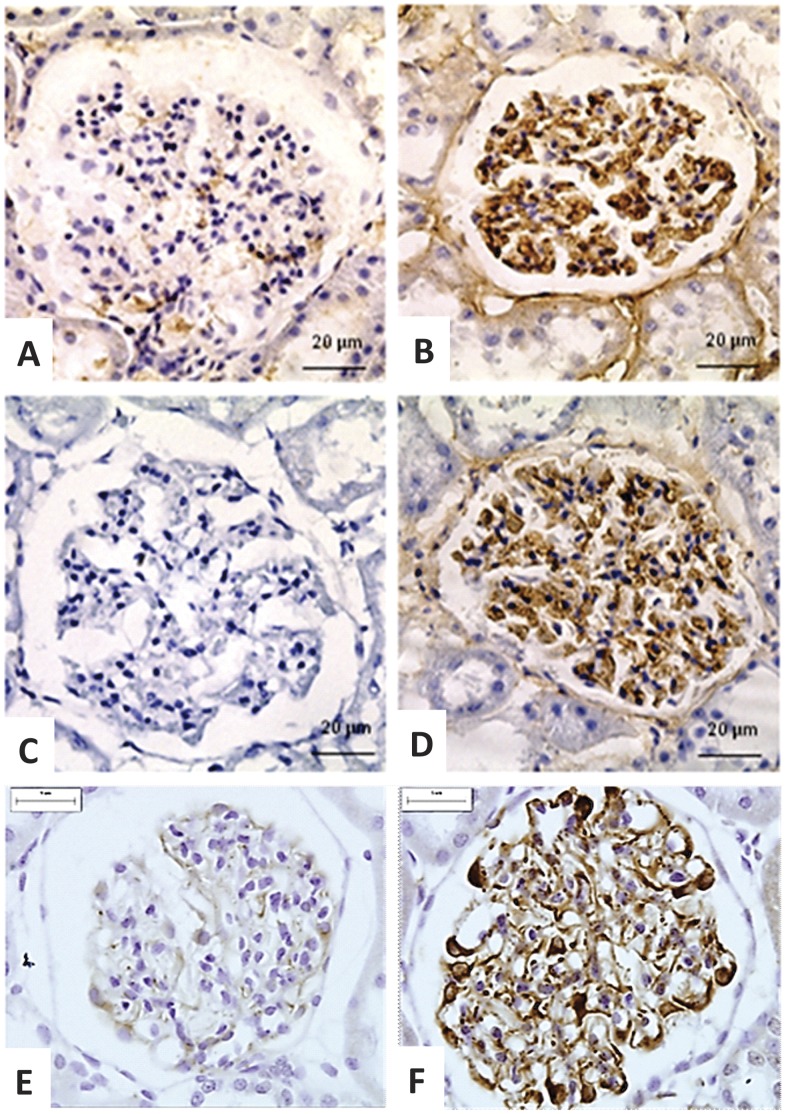
Immunohistochemistry showing enhanced glomerular expression of mesenchymal markers.We verified that fibronectin (B), type I collagen (D) and desmin (F) immunoreactivity are intensively enhanced in LP (n = 5) when compared to that observed in NP (n = 5) (A, C and E, respectively).